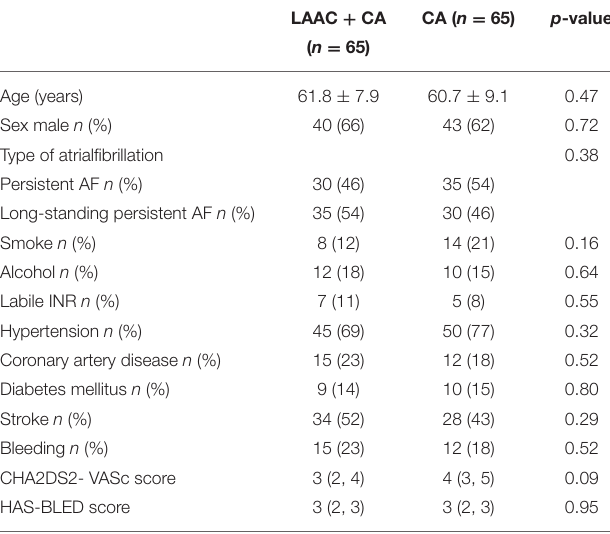
TABLE 1 | Baseline characteristics of the